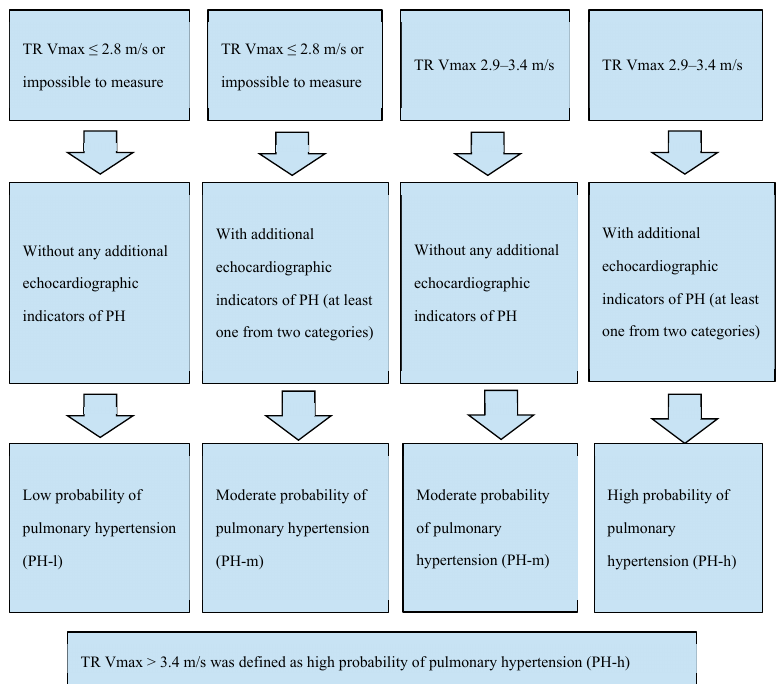
Figure A1. Echocardiographic assessment of pulmonary hypertension. PH—pulmonary hypertension, TR Vmax—Tricuspid valve regurgitation maximal velocity.